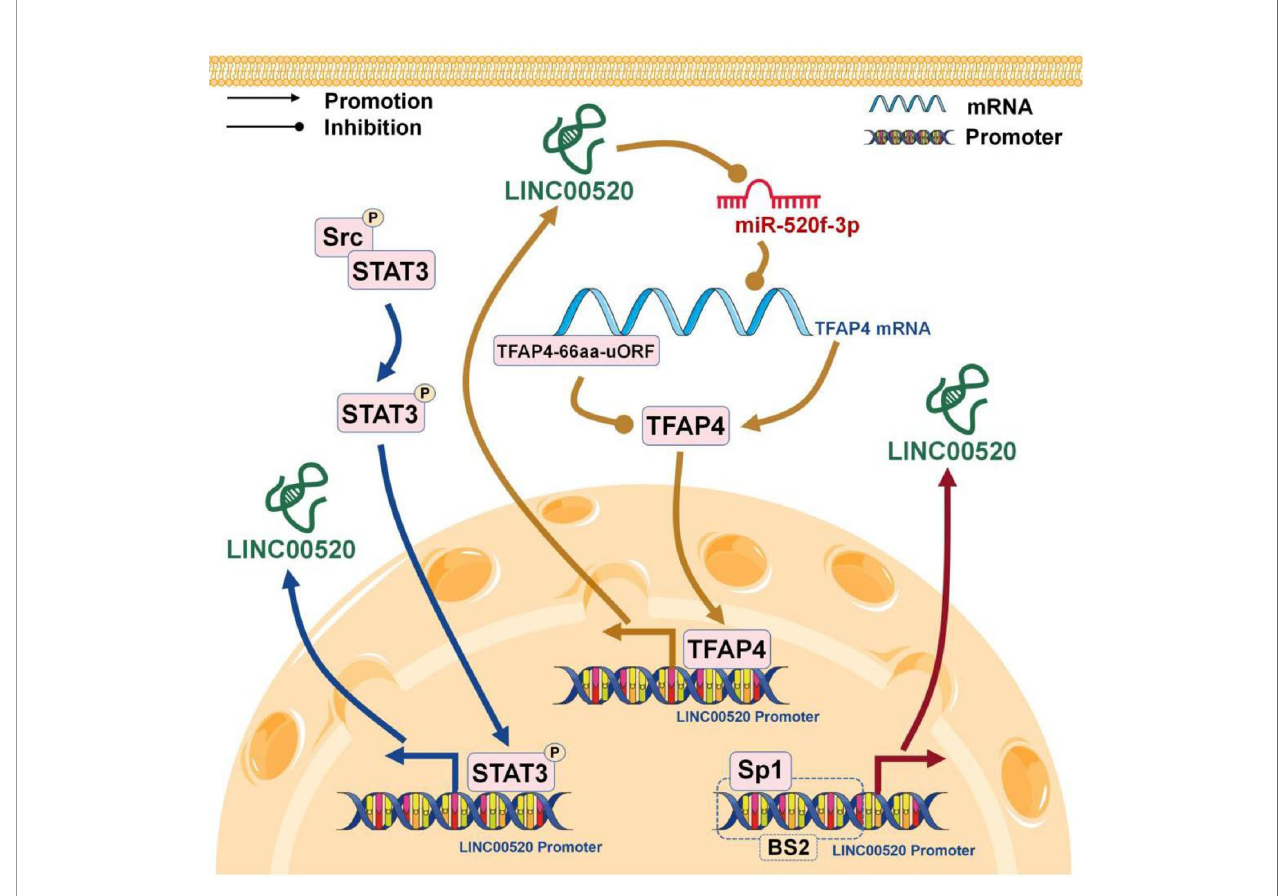
FIGURE 3 | The transcription factors promotes the expression of LINC00520 in cancer.